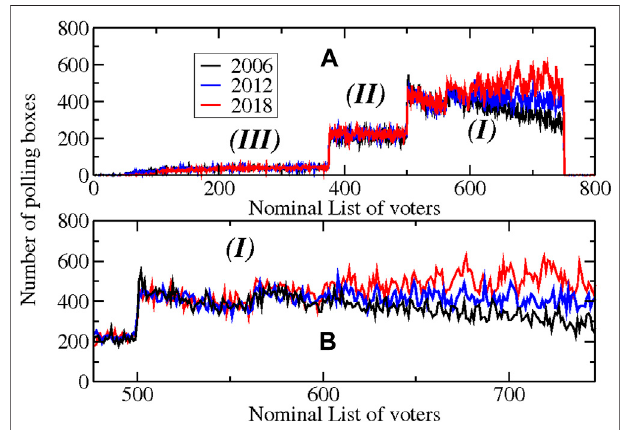
FIGURE 2 | (A) Number of polling boxes with a certain number of voters intheNominalList(NL)forthepresidentialelections2006(inblacklines),2012 (in blue), and 2018 (in red). As can be seen, they present at least three zones with jumps at 375 and 500. We named ( I ) the region with NL between 501 and 750, ( II ) if the NL value is between 376 and 500, and ( III ) for the values smaller than 375. (B) A closeup to the region ( I ) where there is the possibility that a new zone exists between 501 and around 560. Notice that the graphs present a